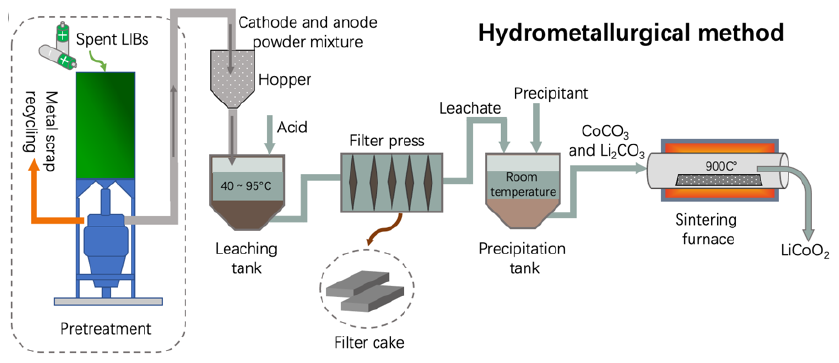
Figure 2. Schematic of the hydrometallurgical method of spent LIB recycling system.